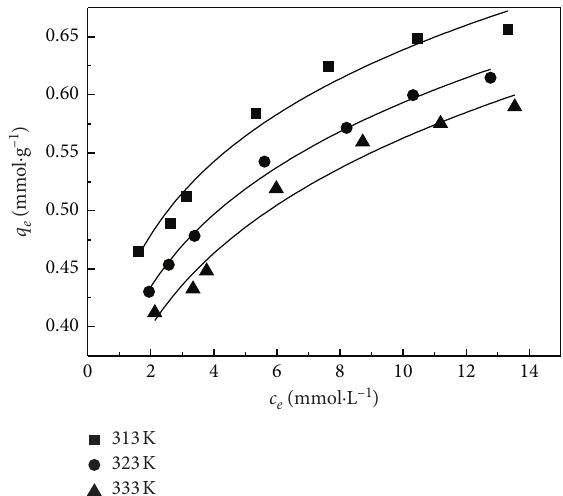
Figure 11: Nonlinear fitting of Langmuir model (adsorbent: 0.2g 2wt. %; v : 20mL; c 0 : 6.25, 7.81, 9.38, 12.50, 15.63, 18.75, and oil 21.88mmol · L − 1 DBT; adsorption time: 4h). Table 2: Nonlinear fitting parameters of three adsorption iso- thermal models (Langmuir, Freundlich, and Temkin) at different adsorption temperatures (313, 323, and 333K).